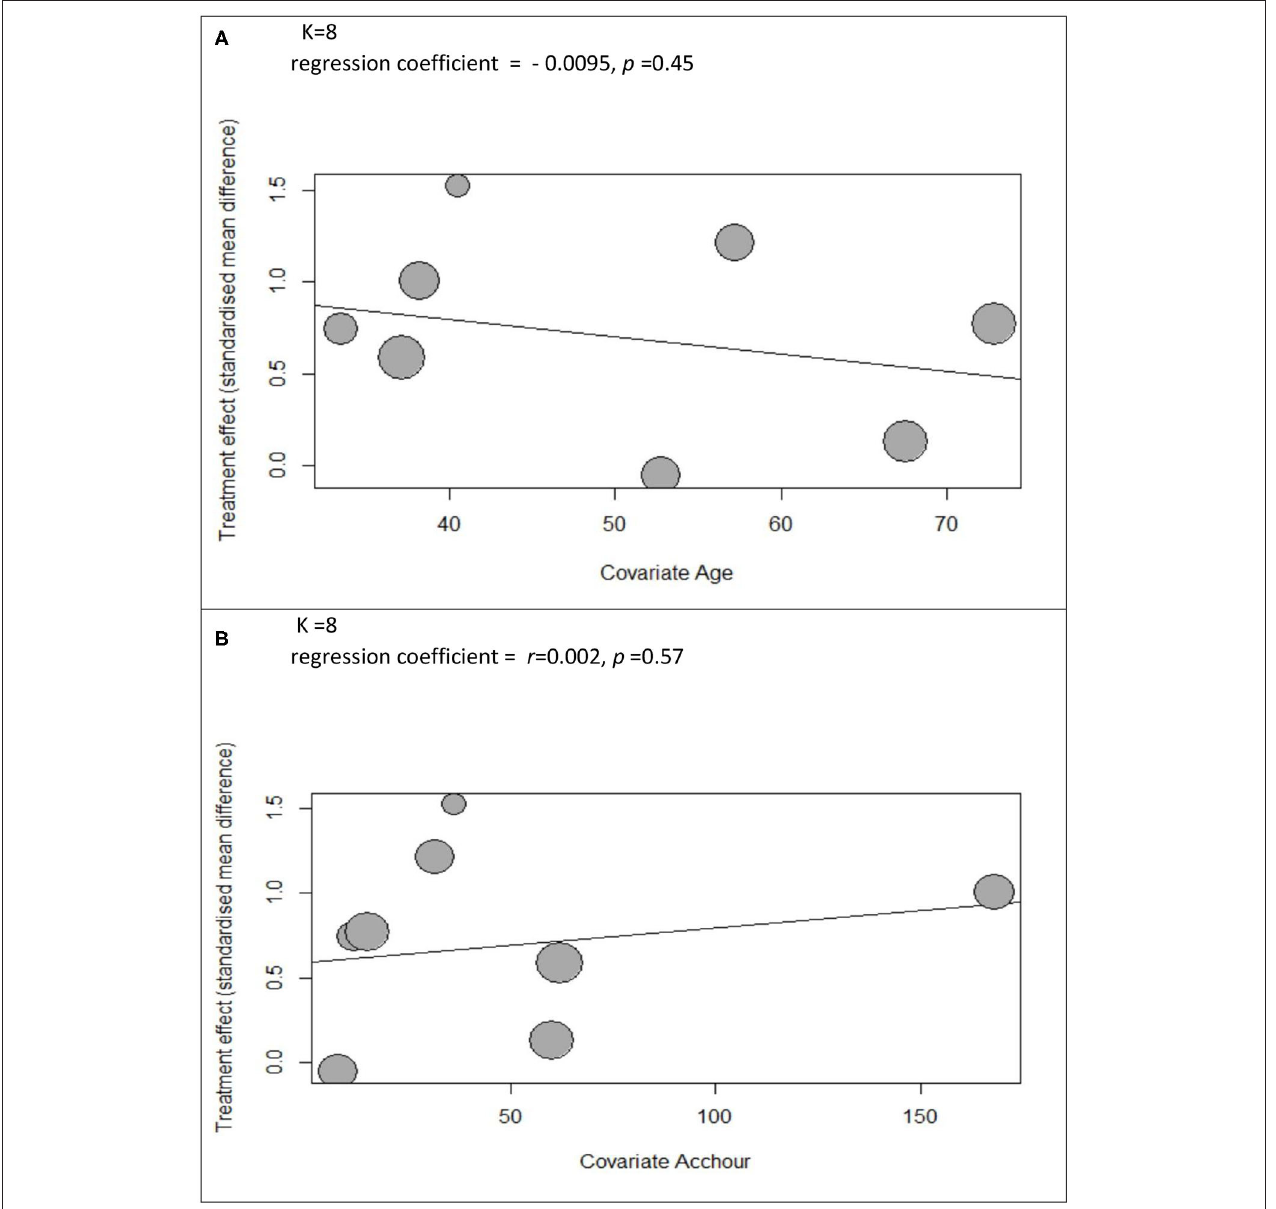
FIGURE 5 | The bubble plots of met regression analysis of (A) participants’ age and (B) accumulated hours of